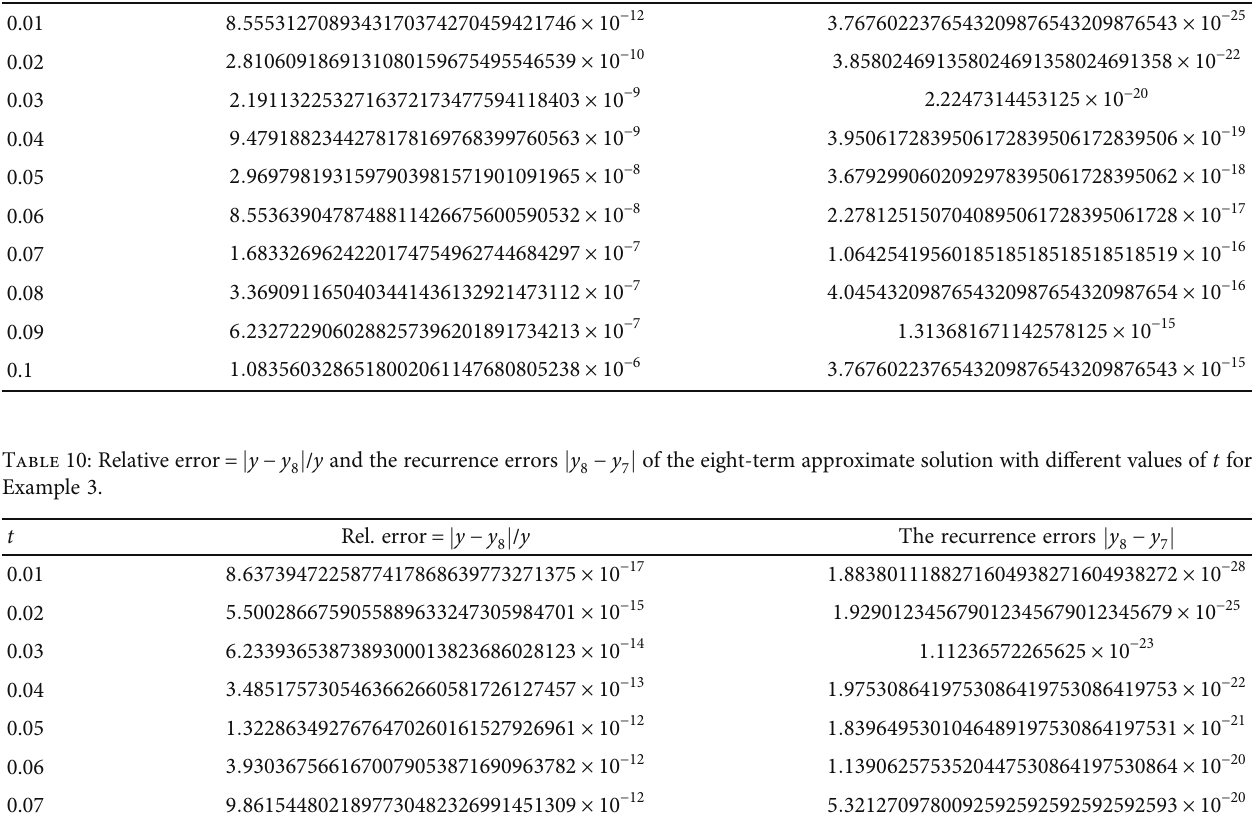
− y 8 7 j of the eight-term approximate solution with di